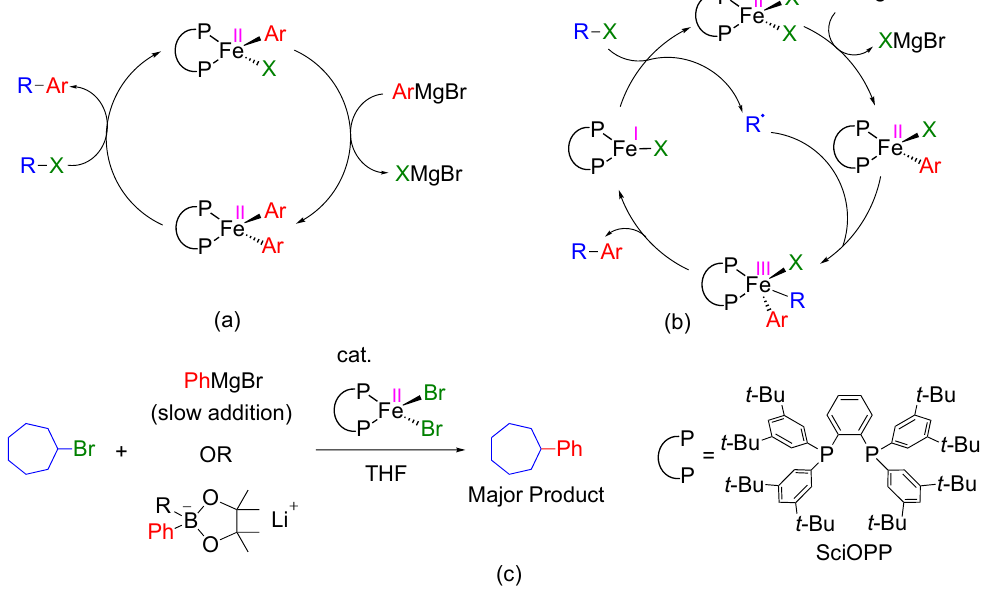
Figure 1. ( a ) Proposed catalytic cycle for cross-coupling between an alkyl halide and Grignard reagent catalyzed by iron-SciOPP complexes. ( b ) Proposed catalytic cycle based on a recent study involving iron-BenzP* catalyzed cross-coupling between α -chloroesters and Grignard reagent. ( c ) The iron-SciOPP-catalyzed cross-coupling reaction chosen for the current density functional theory (DFT) mechanistic study [26,27].